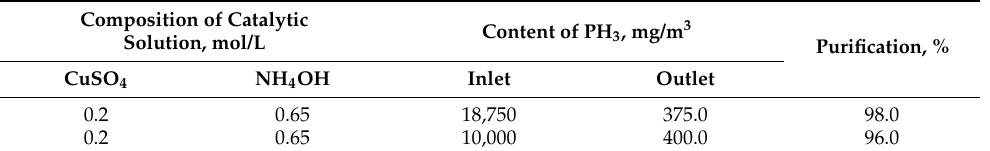
The effect of PH 3 content on the extent of purification from PH 3 at t = 50 ◦ C, V PH3 = 40